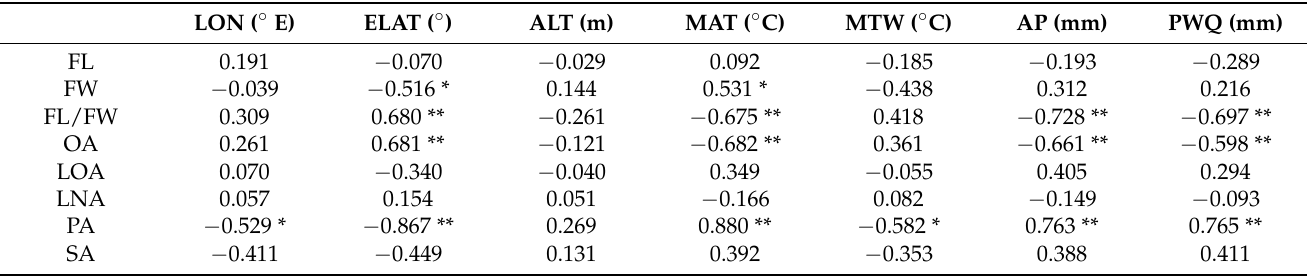
Table 3. Correlation between the environmental factors and morphological characteristics of Camellia oleifera populations.